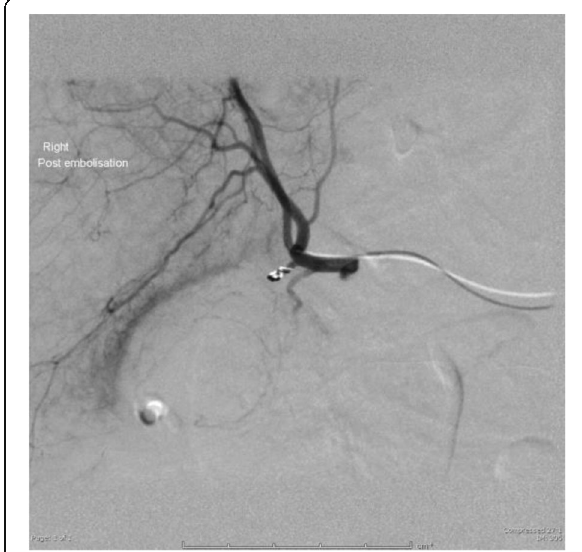
Fig. 5 Post successful cystic artery